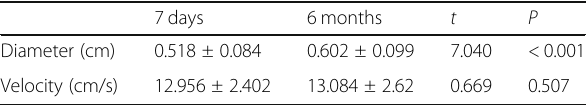
Table 3 Changes of bypass diameter and flow velocity at 7 days and 6 months after operation in Group